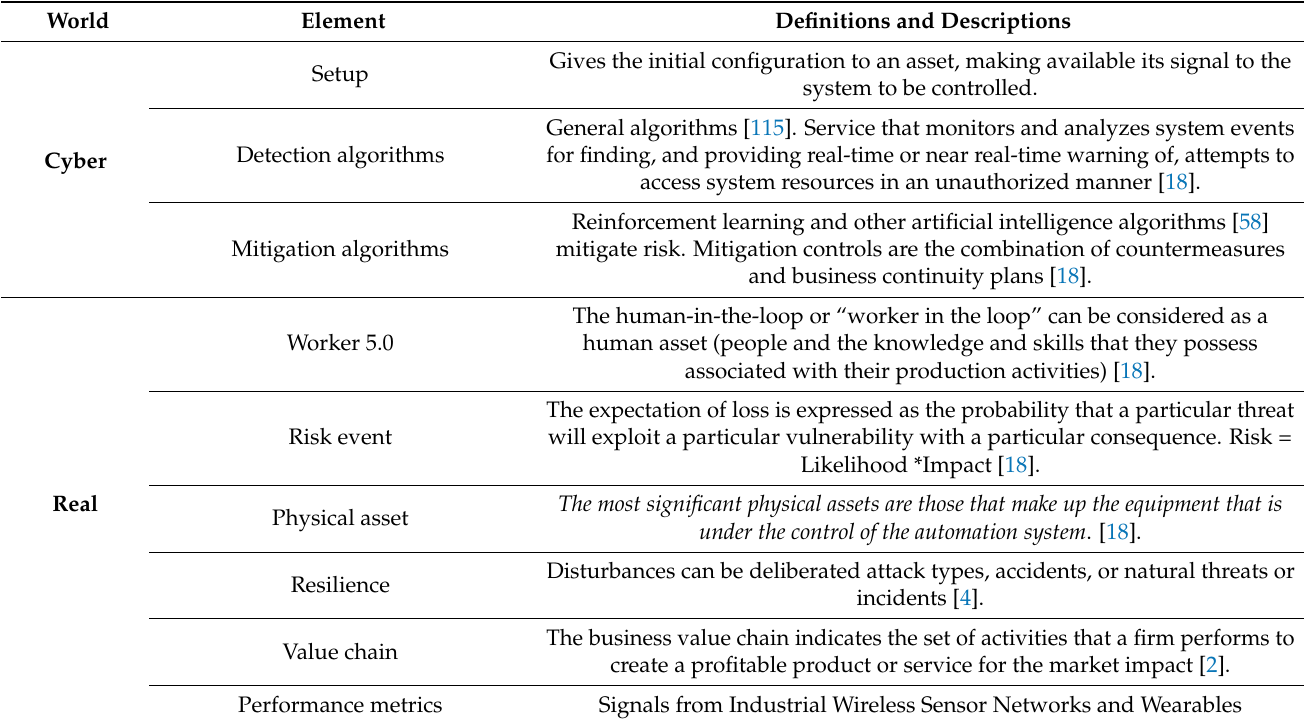
Table 6. Definition of Maintenance 5.0 elements. Own